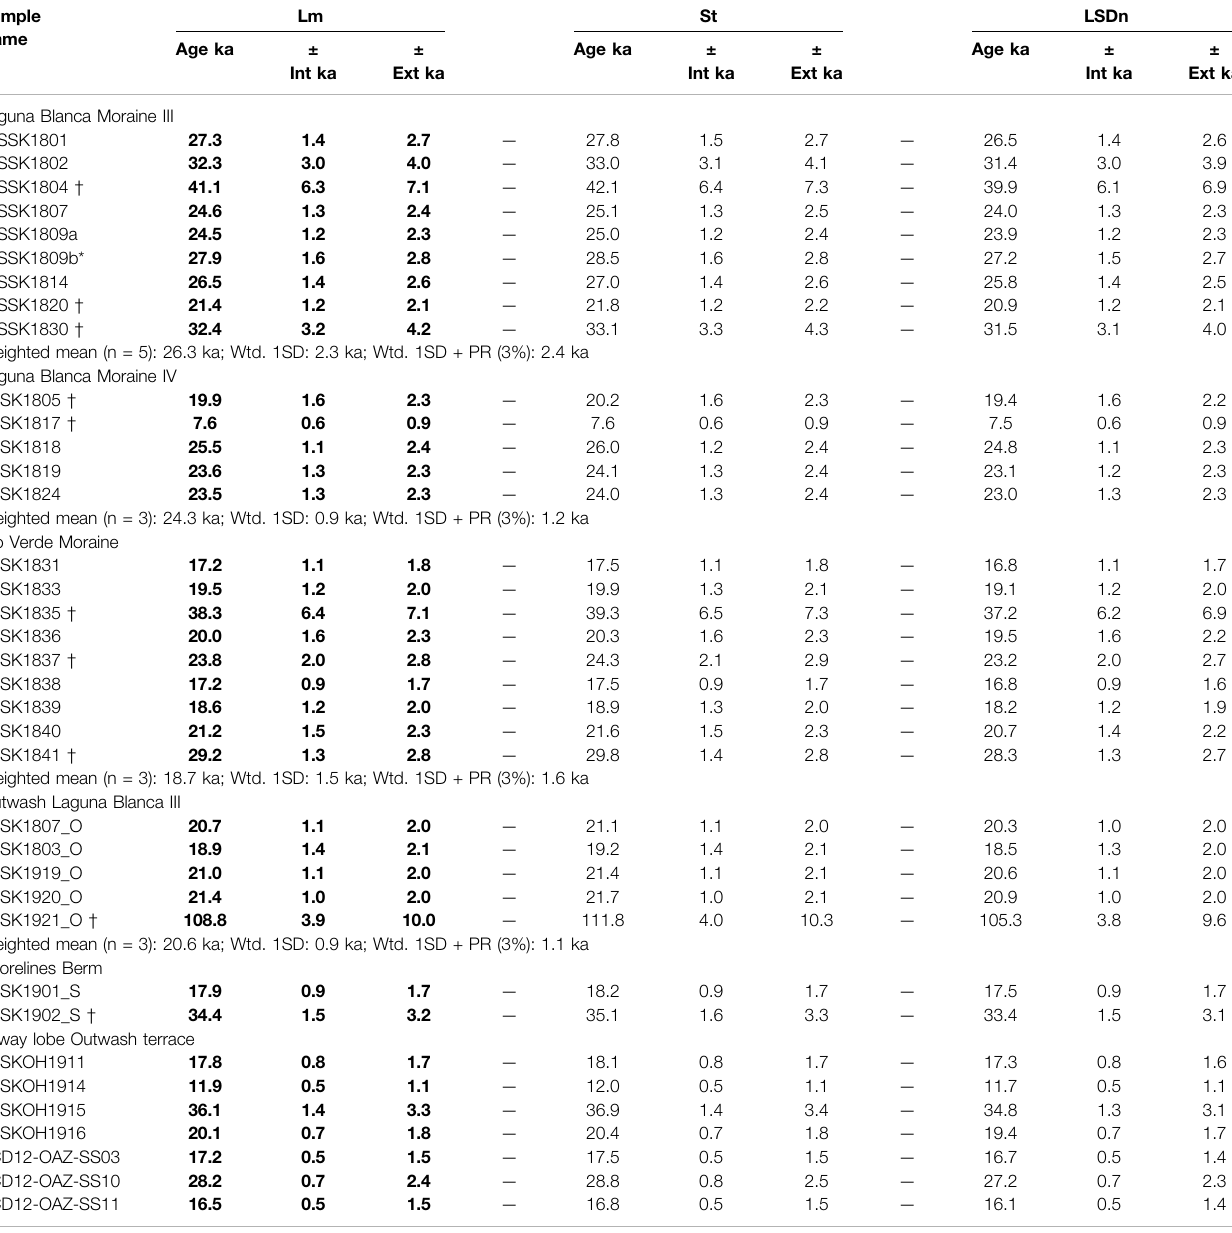
TABLE 2 | 10 Be ages for the study area, assuming 0 erosion